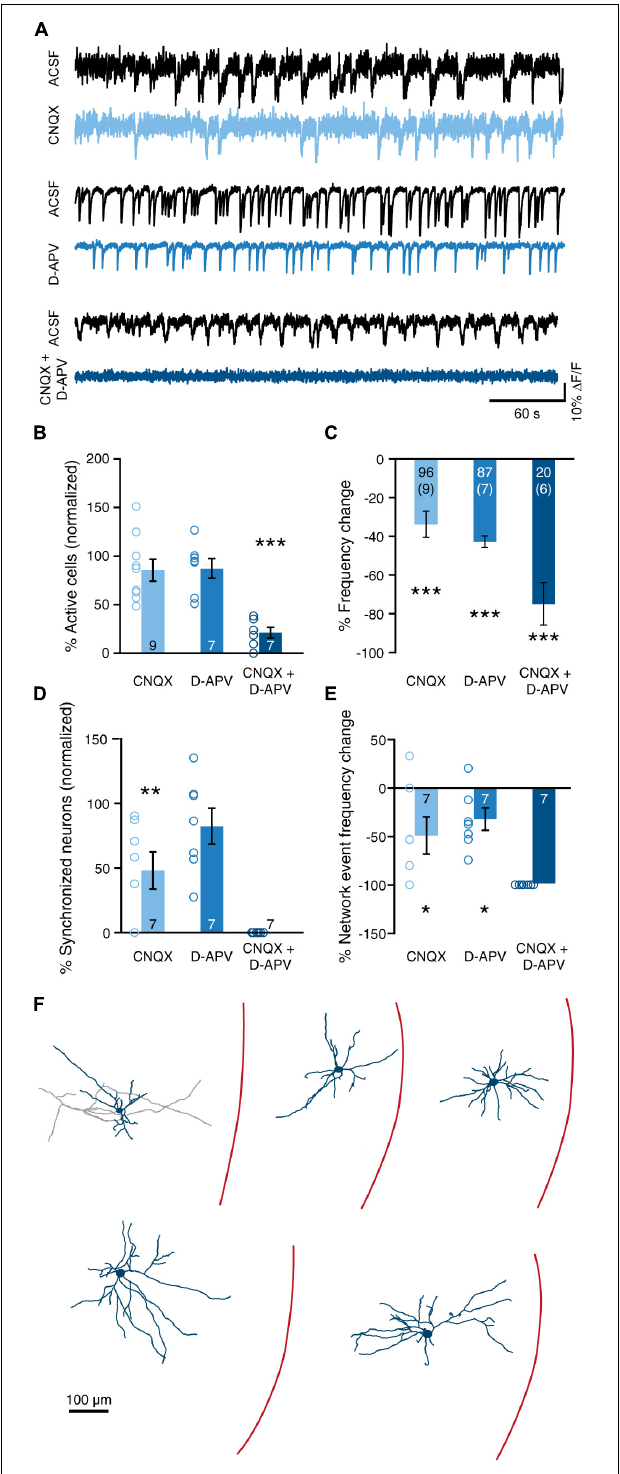
FIGURE 4 | Ionotropic glutamatergic signaling drives spontaneous synchronized network activity in immature sMEC. (A) Example traces of individual neurons before (ACSF, black) and after inhibition of AMPA (CNQX, top) receptors, NMDA (D-APV, middle) receptors, and both